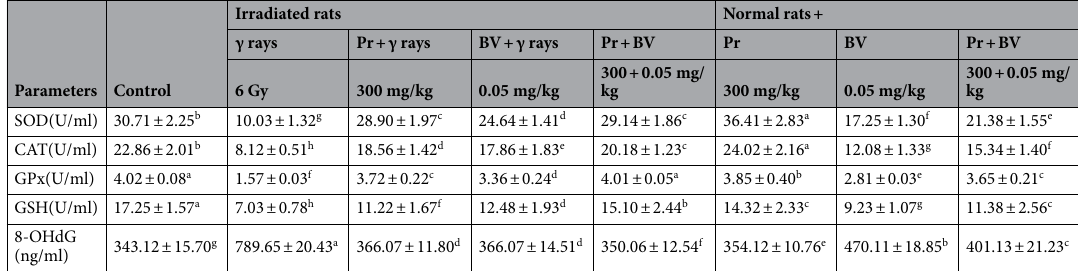
Table 5. Effect of propolis and/ or bee venom on the antioxidant enzymes and 8-OHdG. Values with same superscript in the same raw are not statistically different. Data expressed as mean ± SE, n = 6. The groups are statistically significant (P < 0.05) as compared with control, using one-way ANOVA followed by Duncan’s test as a post-hoc test.